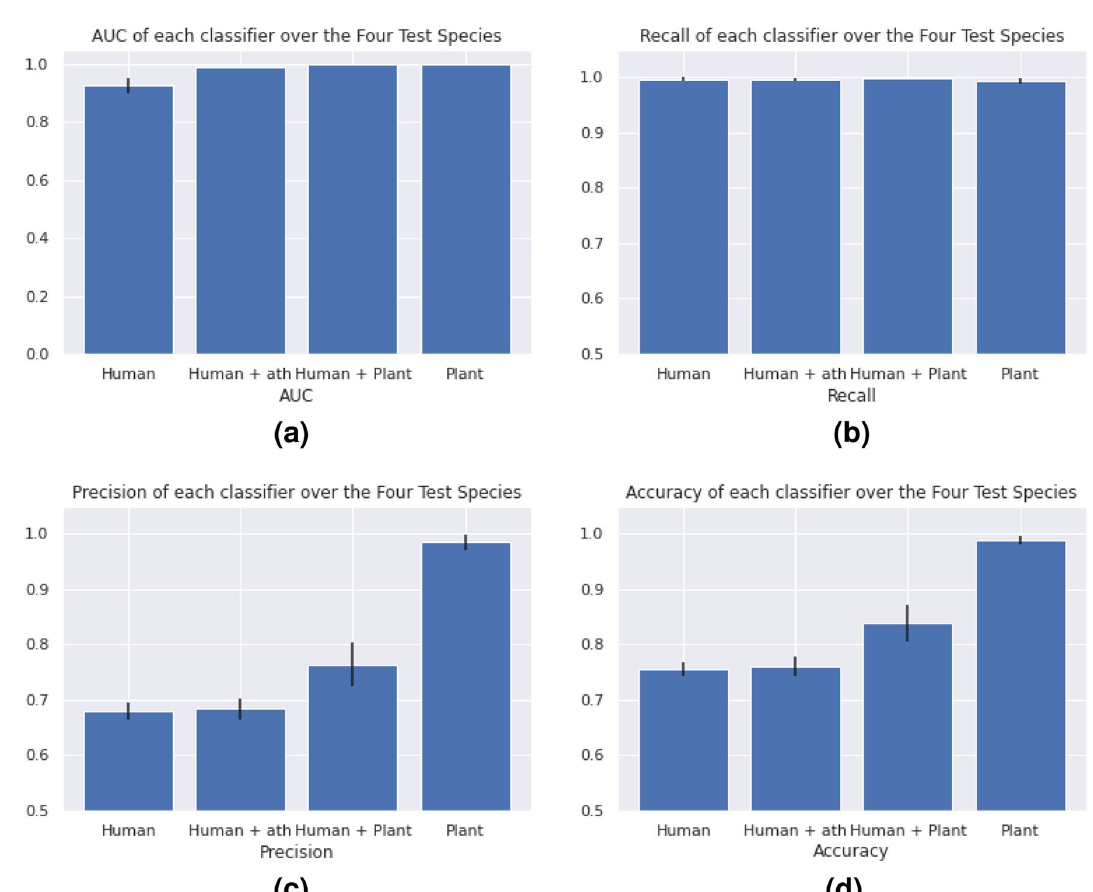
Figure 1. The average value and standard deviation of the performance metrics of each classifier (Human, Human+ath, Human+Plant, and Plant) over the four test species ( Glycine max , Oryza sativa , Populus trichocarpa , and Brachypodium distachyon ). The performance metrics included are area under the Precision– Recall curve (AUC), recall (Re), Precision (Pr), and accuracy